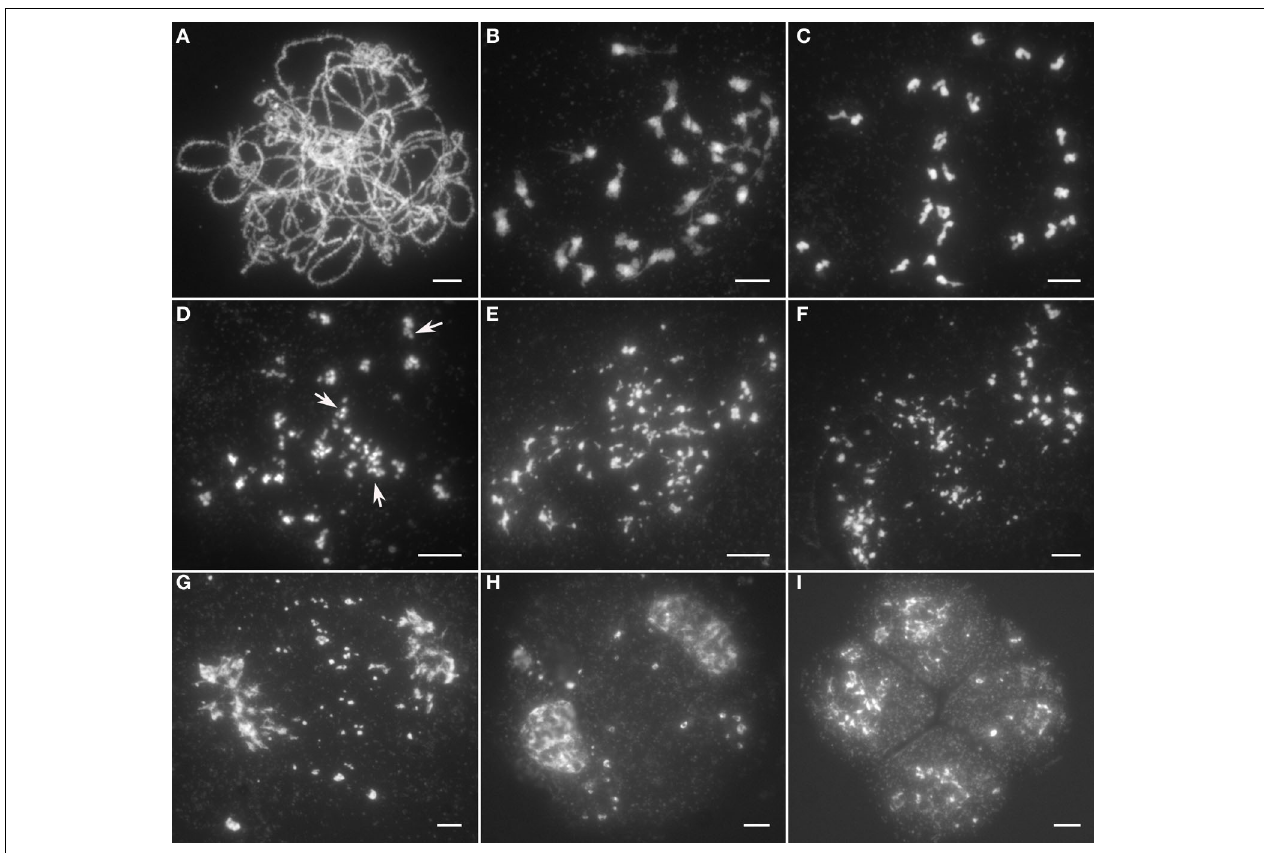
FIGURE 2 | Male meiosis in the Osrad51c mutant. (A) Pachytene; (B) Diakinesis; (C) Early metaphase I; (D) Middle metaphase I; (E) Late metaphase I; (F) Anaphase I; (G) Telophase I; (H) Dyad; (I) Tetrad. Bars, 5 μ m.